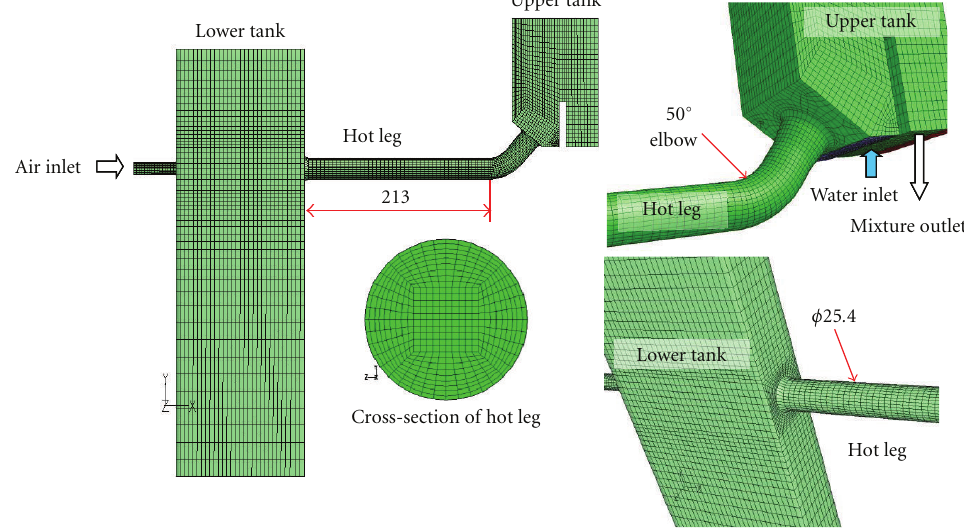
Figure 2: Computational grids (unit: